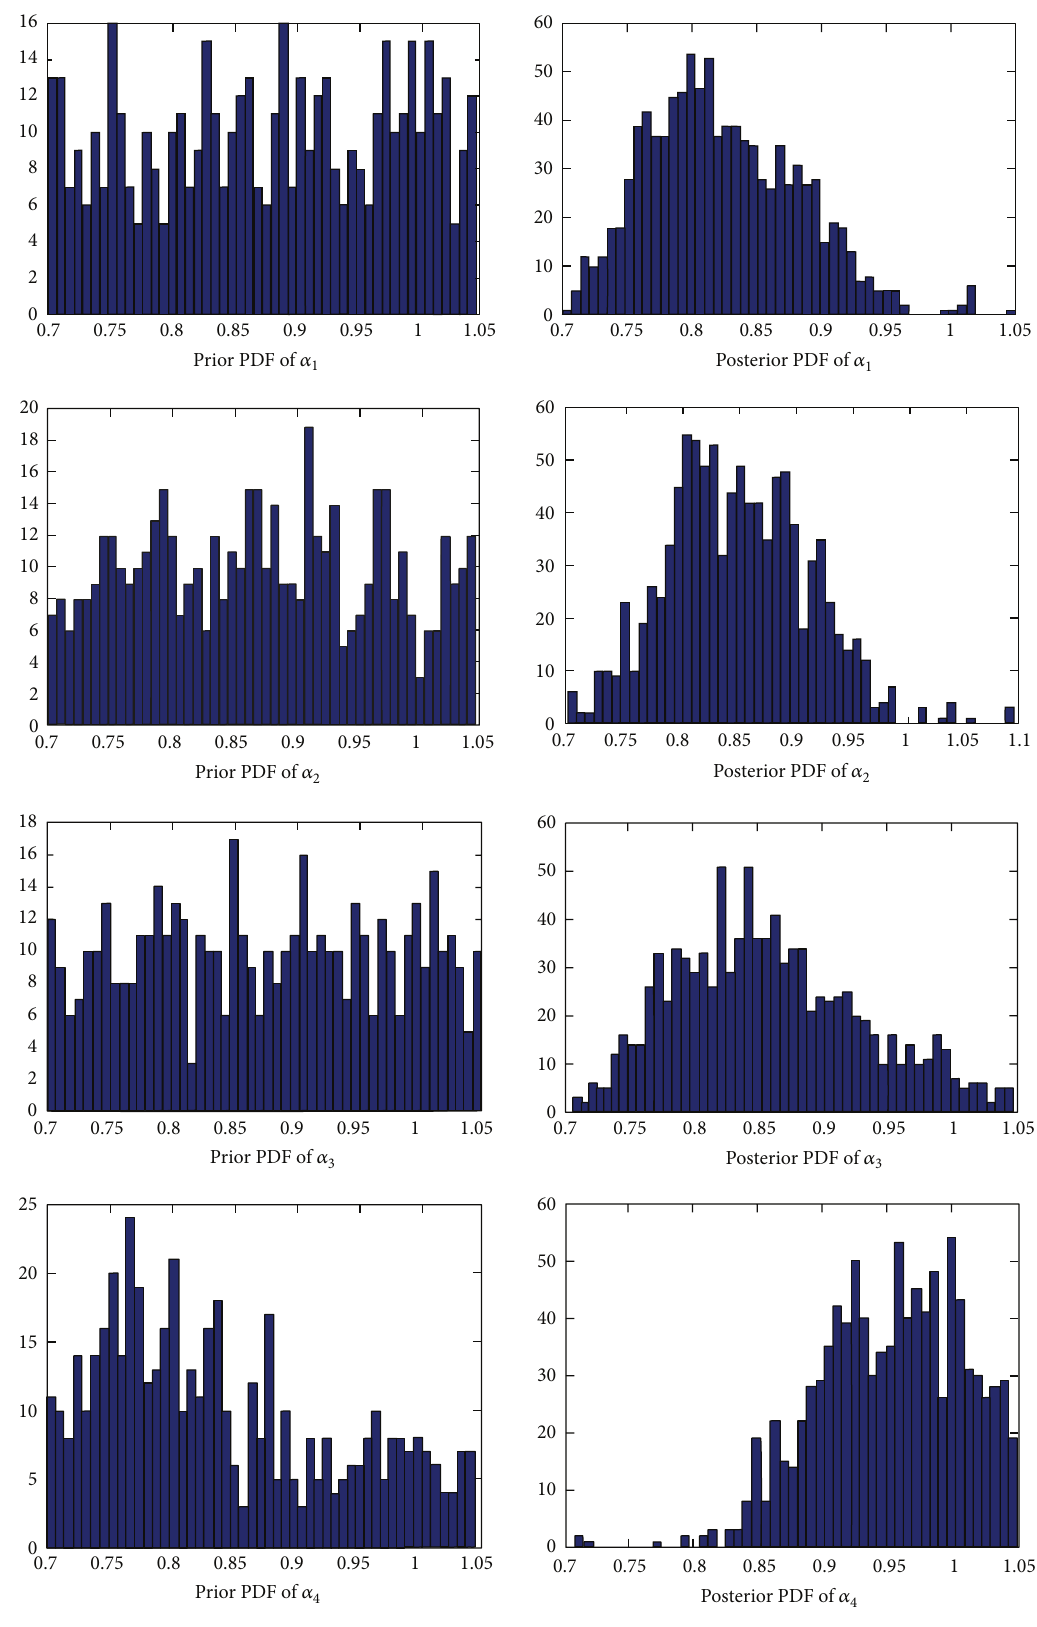
Figure 3: Histograms of PDFs of parameters from 𝛼 1 to 𝛼 4 for the model